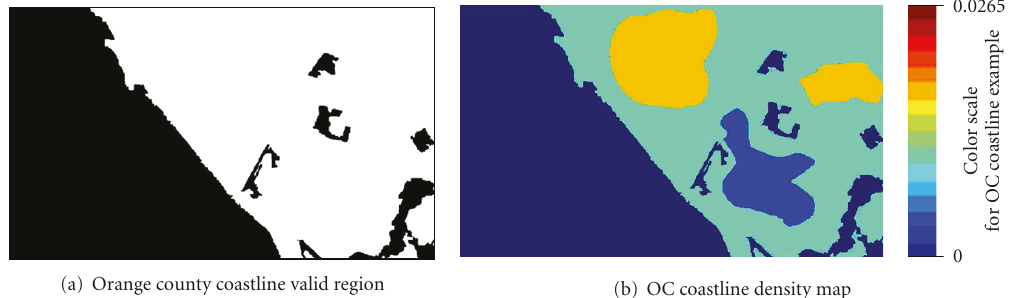
Figure 5: After thresholding the intensity values of Figure 4(c), we obtain the valid region for the Orange County Coastline. This valid region is shown in (a). We then constructed a probability density shown in figure (b). The color scale represents the relative probability of an event occurring per square kilometer.